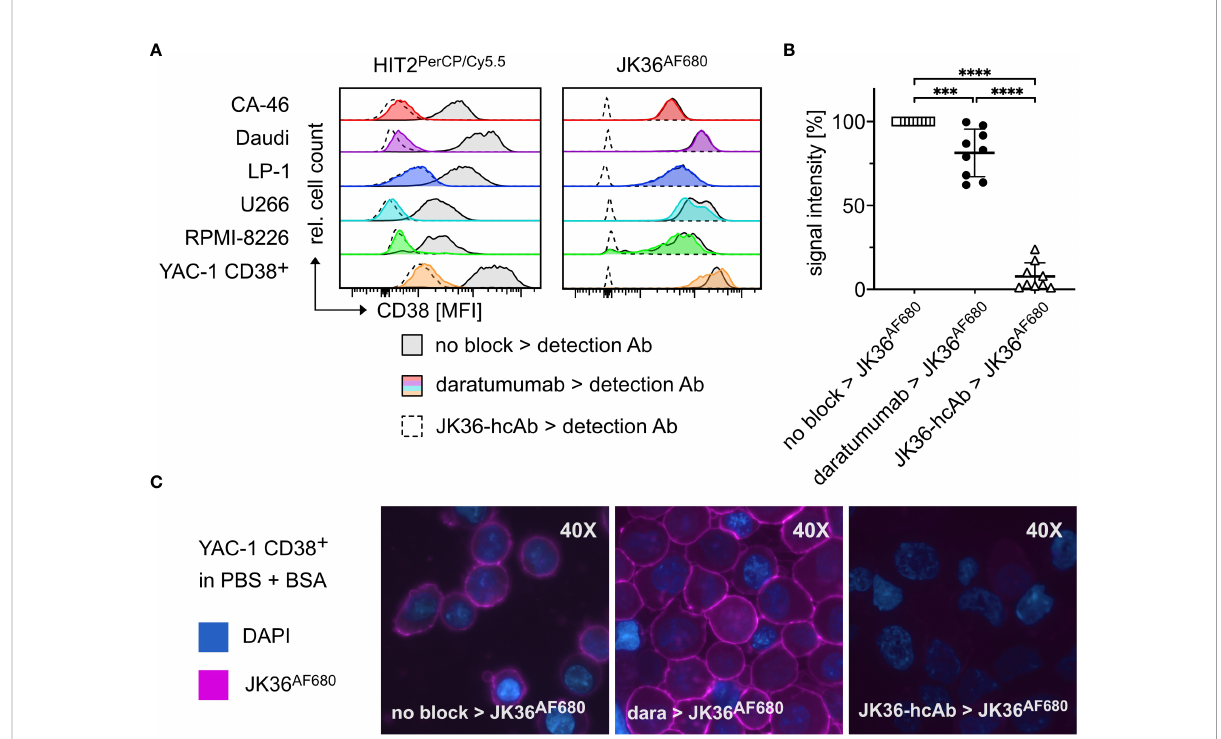
FIGURE 3 Speci fi c binding of nanobody JK36 AF680 to daratumumab-pretreated myeloma cells in vitro and ex vivo . (A) FACS analyses of CD38+ CA-46, Daudi, LP-1, U266, RPMI-8226, and YAC-1 CD38+ cells. Cells were saturated with daratumumab before detection of CD38 with the CD38- speci fi c diagnostic antibody HIT2 PerCP/Cy5.5 (left) or the CD38-speci fi c nanobody JK36 AF680 (right). Cells saturated with JK36-hcAb served as negative controls since previous experiments had shown complete blocking of both JK36 AF680 and HIT2 PerCP/Cy5.5 binding after incubation with JK36-hcAb. Untreated cells were used as positive controls and indicate CD38 expression of the cell line. (B) Bone marrow aspirates of human multiple myeloma patients were pre-incubated without (open rectangles, positive control) or with saturating doses of daratumumab (black circles) or JK36-hcAb (open triangles, negative control). CD38 was then labeled using JK36 AF680 and cells were analyzed by fl ow cytometry for comparison of epitope blocking by daratumumab and JK36-hcAb. Signal intensities were compared using one-way ANOVA with Tukey ’ s multiple comparisons test (****= p<0.0001, ***=p<0.001). Depicted are means ± SD. Results are representative of nine independent experiments. (C) Fluorescence microscopy analyses of YAC-1 CD38+ cells. Cells were incubated with PBS/BSA (left panel), daratumumab (middle panel), or JK36-hcAb (right panel) before the addition of JK36 AF680 . DAPI was used to stain nuclei. Results are representative of three independent